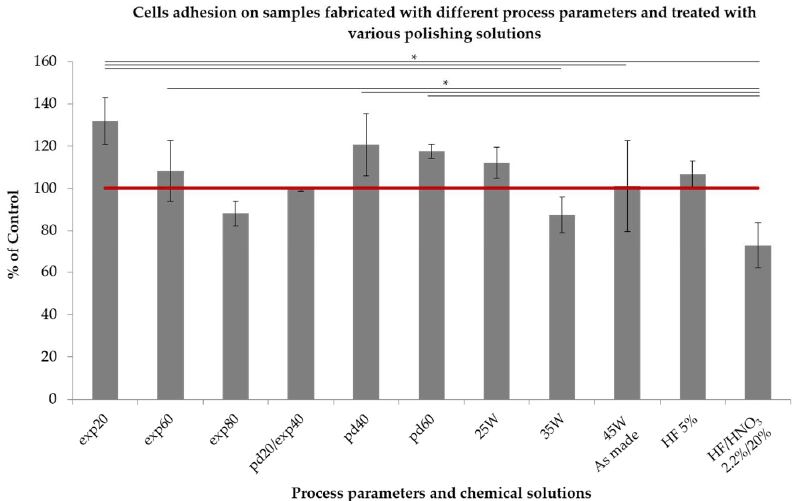
Figure 5. Cells adhesion after 4 h of incubation measured by means of MTS assay. Sample encoded pd20 represent also samples exp40. Samples encoded 45 W were used for chemical polishing, therefore they represent “as-made” reference sample. hMSCs metabolic activity was normalized to the control (100%, red line). *—Significant difference between indicated groups (* p < 0.05).